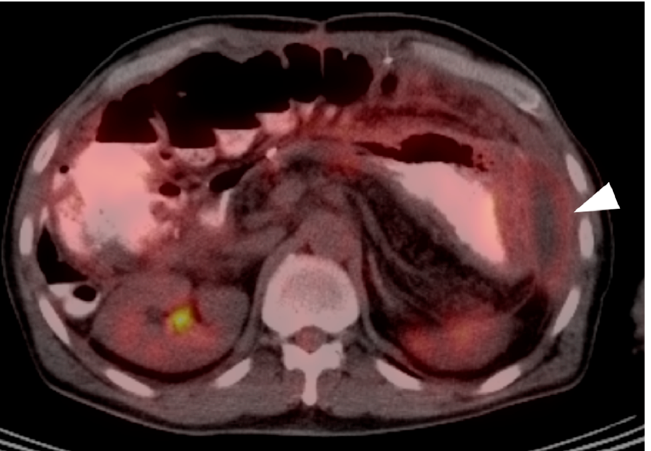
Figure 29. Peritoneal carcinomatosis from recurrent pancreatic cancer. Axial fused FDG PET-CT images. ( a ) The peritoneal surface is diffusely lined with tumor (white arrowhead). ( b , c ) There is omental caking with hypermetabolic tumor (white arrowheads).